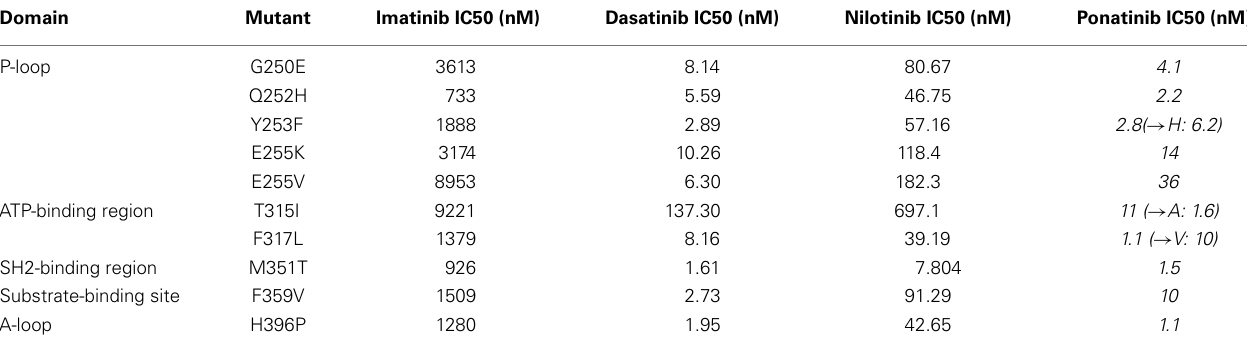
Table 2 |Activity (IC50) of imatinib, dasatinib, nilotinib, and ponatinib against selected BCR–ABL1 mutants . Domain